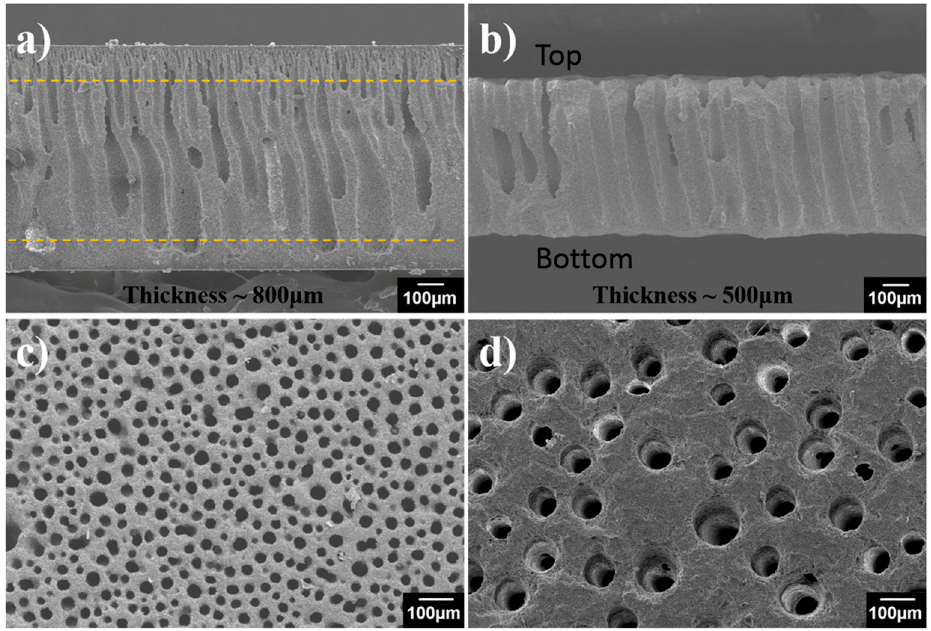
Figure 2. Scanning electron microscope (SEM) images of the as-prepared alumina membrane. ( a ) Cross-section before polishing, ( b ) cross-section after polishing, ( c ) top surface, and ( d ) bot- tom